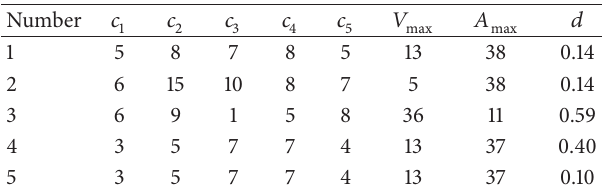
Table 4: The simulation